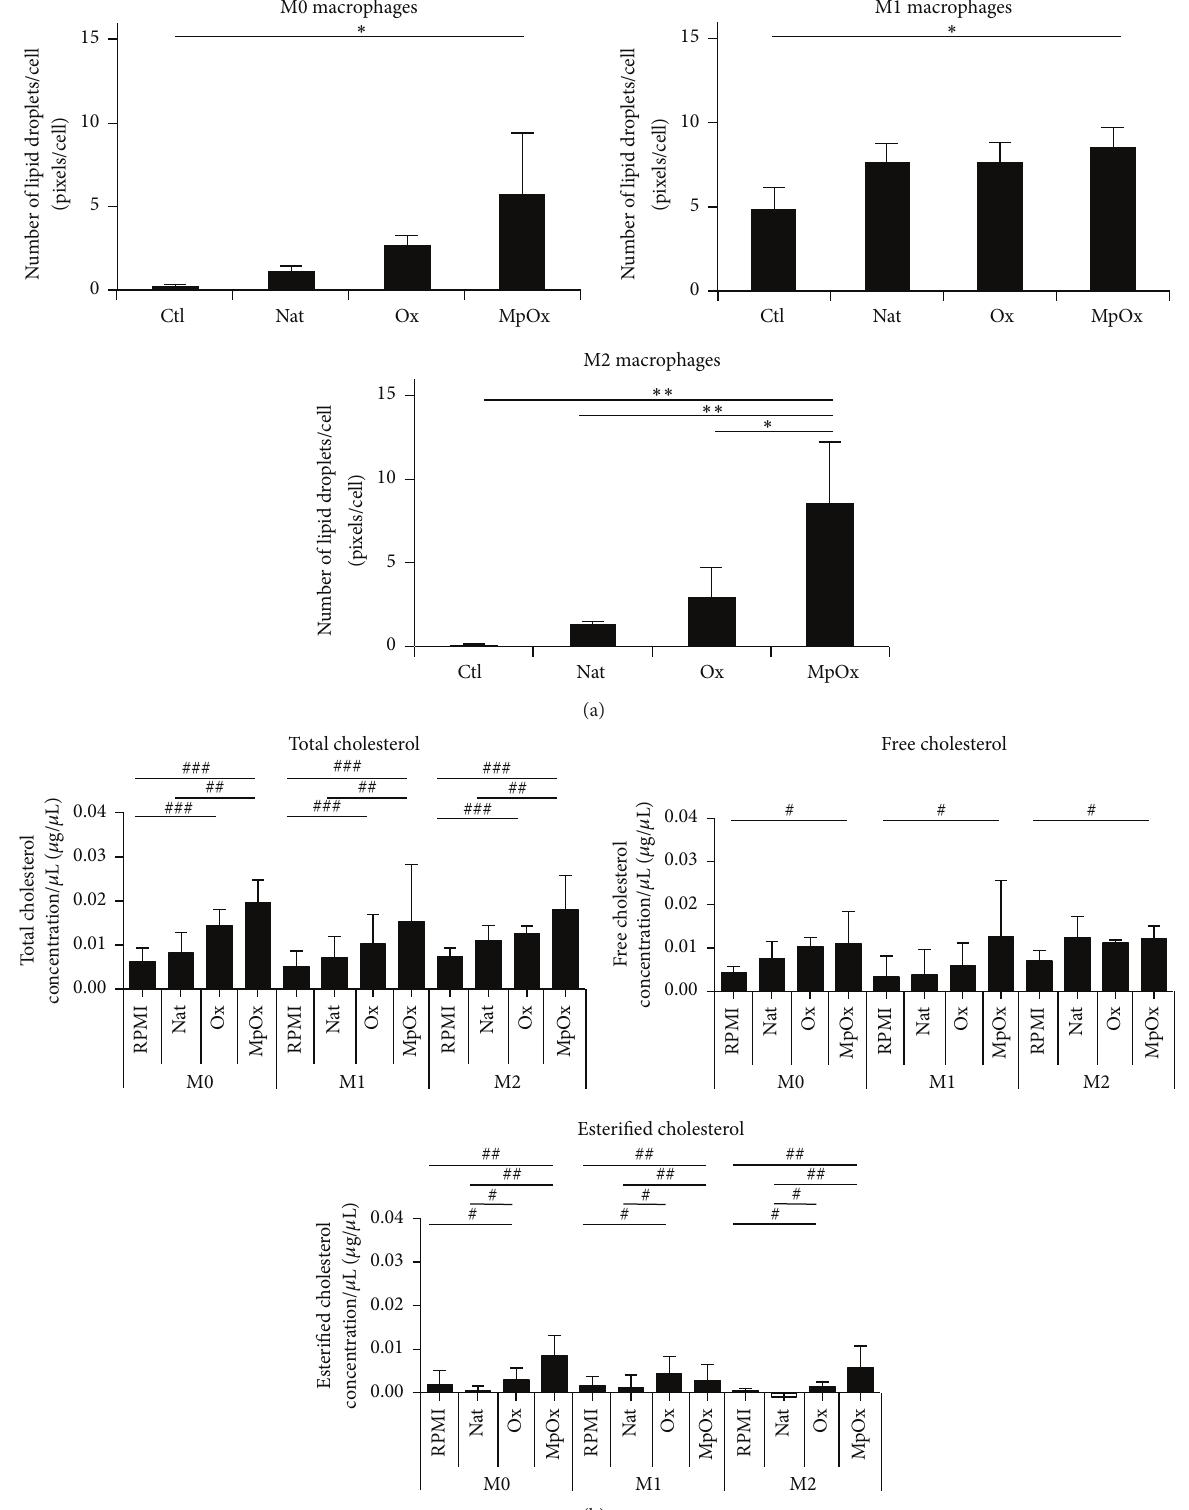
Figure 7: Comparative effects of LDLs on (un)polarized BMDMs to induce foam cells. (a) M0, M1, and M2 macrophages were incubated in the presence or absence of Nat-LDLs, Ox-LDLs, and MpOx-LDLs (100 𝜇 g/mL) for 24 hours. The number of lipid droplets was estimated using a High Content Imager, as described in Materials and Methods. Data are expressed as mean ± SD ( 𝑛 = 4 ). ANOVA 1: ∗ 𝑝 < 0.05 and ∗∗∗ 𝑝 < 0.001 . (b) Intracellular cholesterol content in M0, M1, and M2 macrophages incubated in the presence or absence of Nat-LDLs, Ox-LDLs, and MpOx-LDLs for 24 hours. The intracellular cholesterol was measured by a colorimetric assay (absorbance: 570 nm). Data are expressed as 𝜇 g/ 𝜇 L of free, esterified, and total cholesterol (mean ± SD ( 𝑛 = 3 )). Data were analyzed by a Kruskal-Wallis ANOVA on ranks. ANOVA 1: ∗ 𝑝 < 0.05 and ∗∗ 𝑝 < 0.01